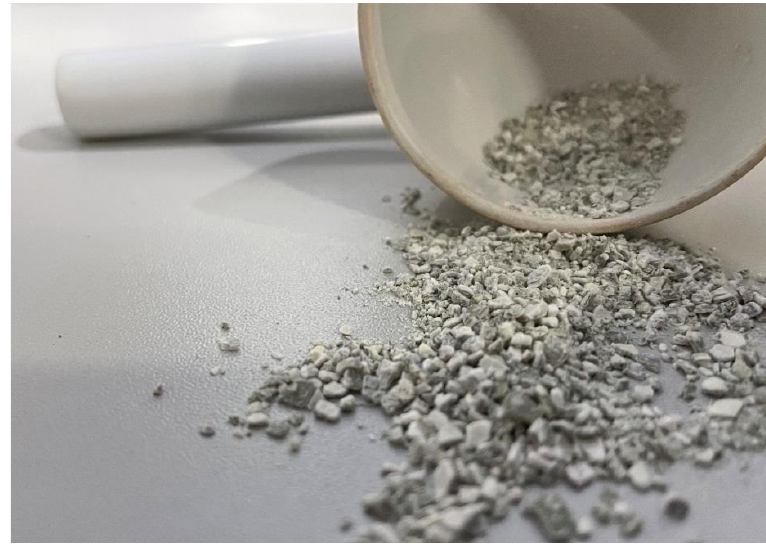
Figure 2. Bioclast tested for evaluate their possible applications in circular economy.